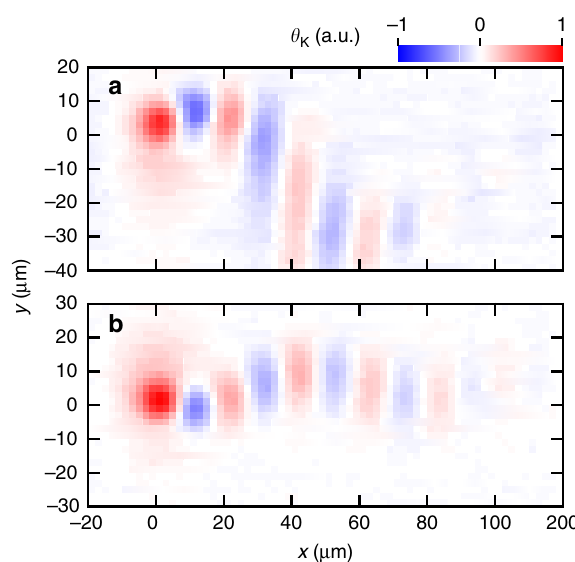
Figure 4 | Dynamic modulation of transport path of drifting spins. ( a , b ) Drift spin transport driven by V dc 100mV with sinusoidal voltage x ¼ 200mV applied in the x and y direction, respectively. The frequency V ac y ¼ was adjusted to the repetition frequency of the mode-locked of the V ac y laser, 82.46MHz ( a ) or twice the frequency ( b